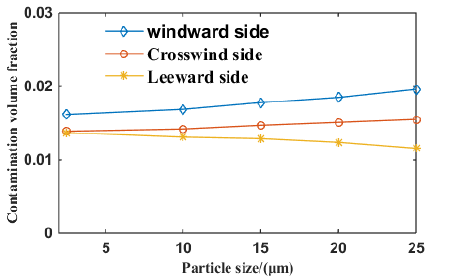
Figure 26. Contamination volume fraction of 1# insulator under different particle sizes.